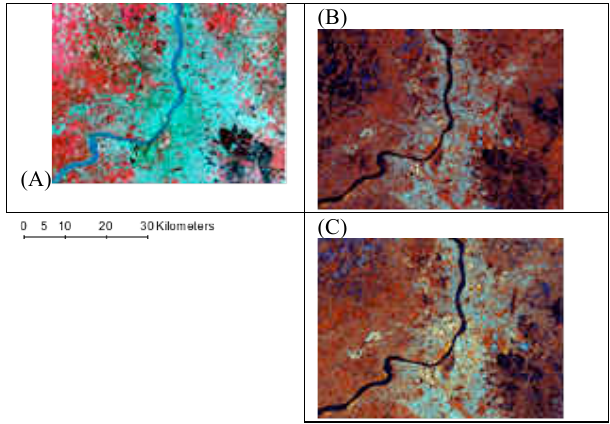
Figure 1: Study Area: (A) Landsat 8 image (band 5, band 4, band 3); (B) 24th July, 2015 (VH, VV, VV/VH); (C) 15th December, 2015 (VH, VV,